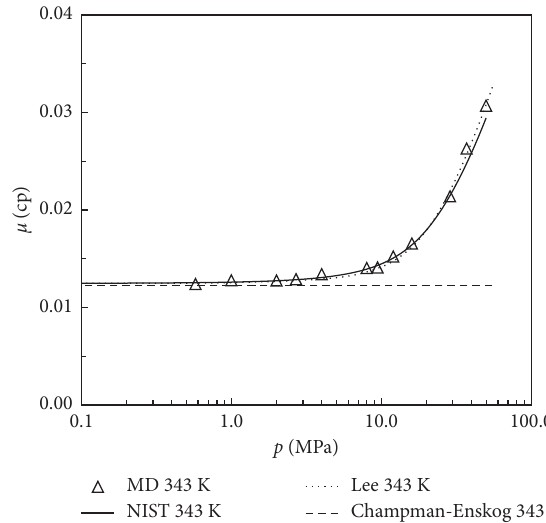
Figure 4: Comparison of bulk methane viscosity results by using different